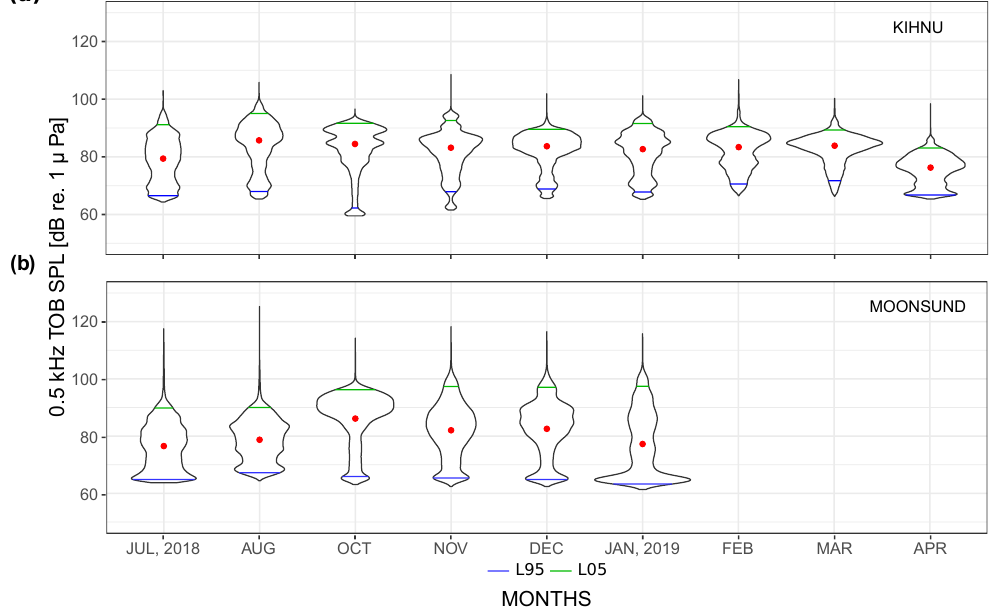
Figure 9. The monthly estimated probability density functions (PDFs) in 500 Hz TOB SPLs: at ( a ) Kihnu and ( b ) Moonsund monitoring location. Red points mark the arithmetic mean values. Blue and green horizontal lines inside the violin plots mark the exceedance levels L95 and L05,